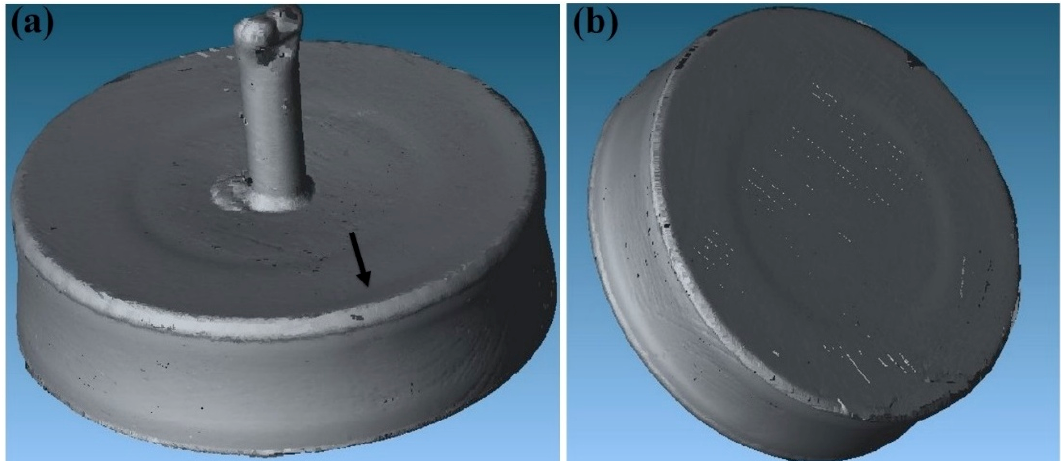
Figure 10. Images of the components after HIPping, as scanned using a Faro laser scanner: ( a ) top view of the component showing a shallow sink mark in the middle part and a small concave area indicated in the image due to less powder filled into the groove; ( b ) clearer contraction evenly towards the centre of the components and a shallow sink mark on the bottom of the canister.